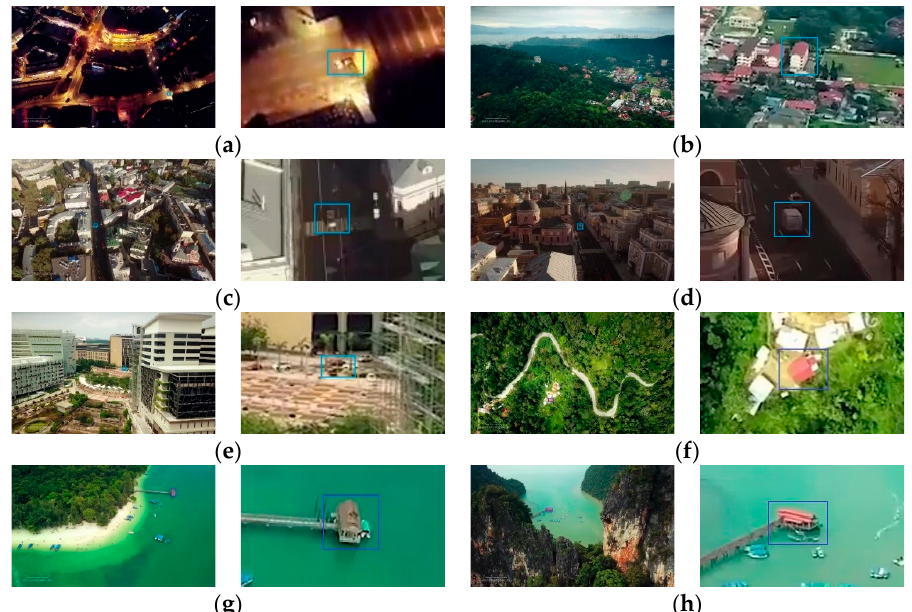
Figure 8. Experimental data. ( a ) car in night; ( b ) house in mountain; ( c ) car in road (high FOV); ( d ) car in road (low FOV); ( e ) target with occlusion; ( f ) target (no occlusion); ( g ) house in lake (close distance); ( h ) house in lake (remote